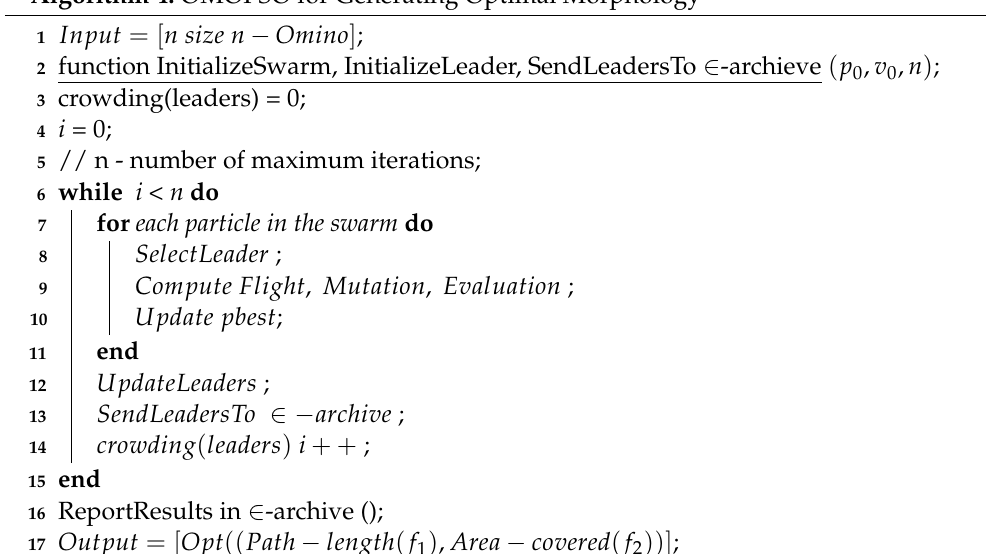
Algorithm 4: OMOPSO for Generating Optimal Morphology